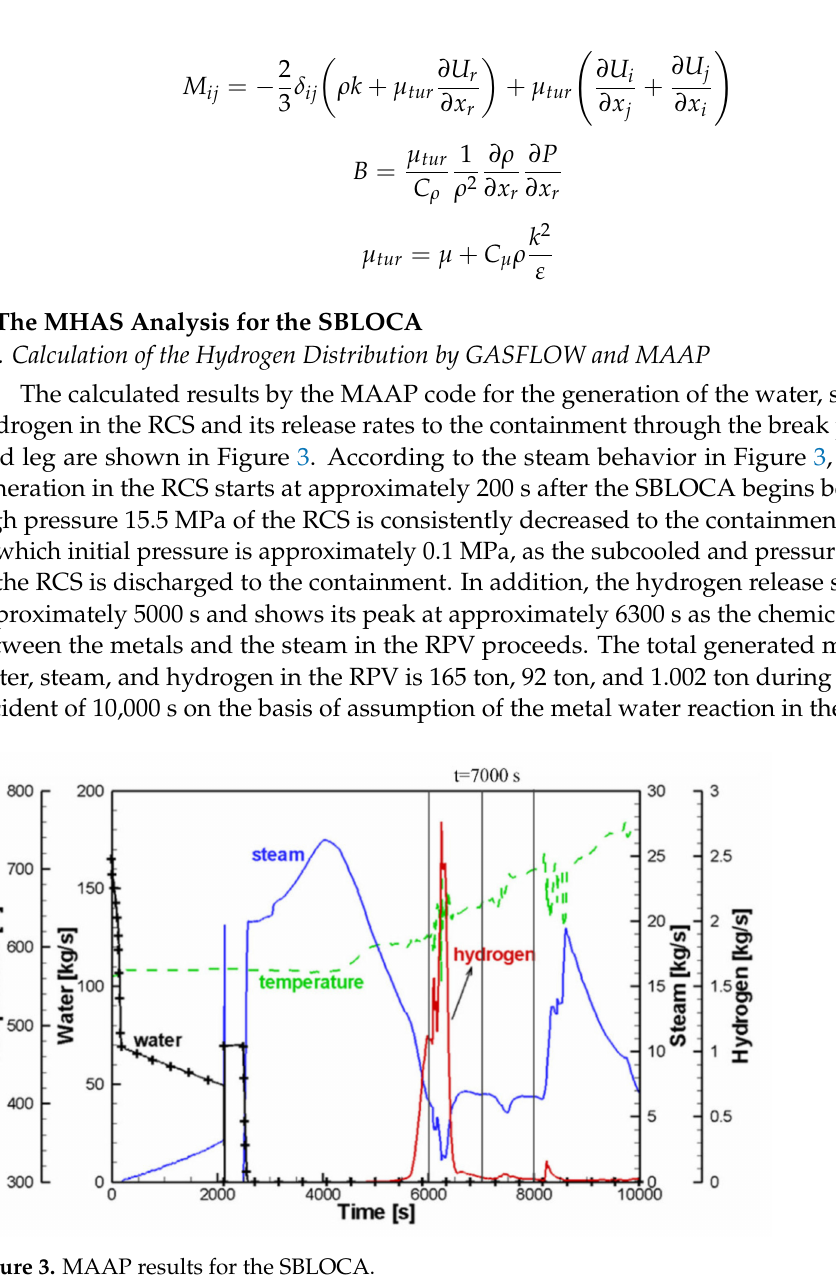
Figure 3. MAAP results for the